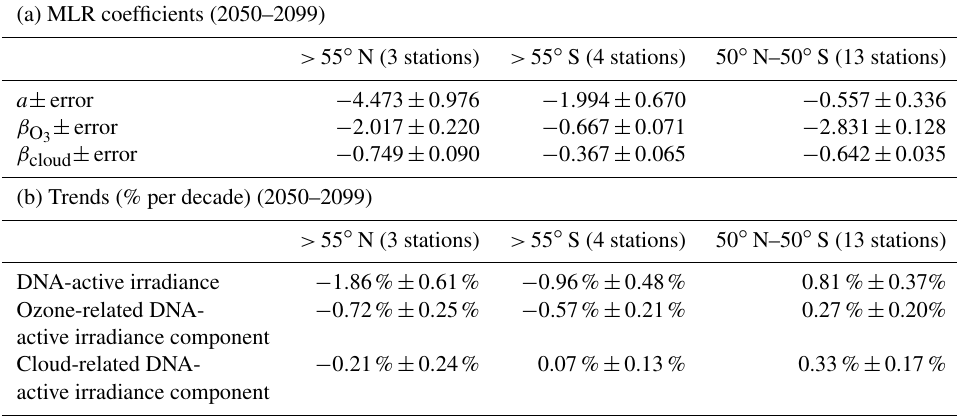
Table 6. (a) Coefficients of multiple regression analysis according to Eq. (7), applied to the differences between the two model simulations – REF and FIX – for the period 2050–2099, for the northern high-latitude stations ( > 55 ◦ N), the southern high-latitude stations ( > 55 ◦ S), and the stations between 50 ◦ N–50 ◦ S. (b) Trends (% per decade) for the period 2050–2099 in the DNA-active irradiance, the ozone-related DNA-active irradiance component, and the cloud-related DNA-active irradiance component.